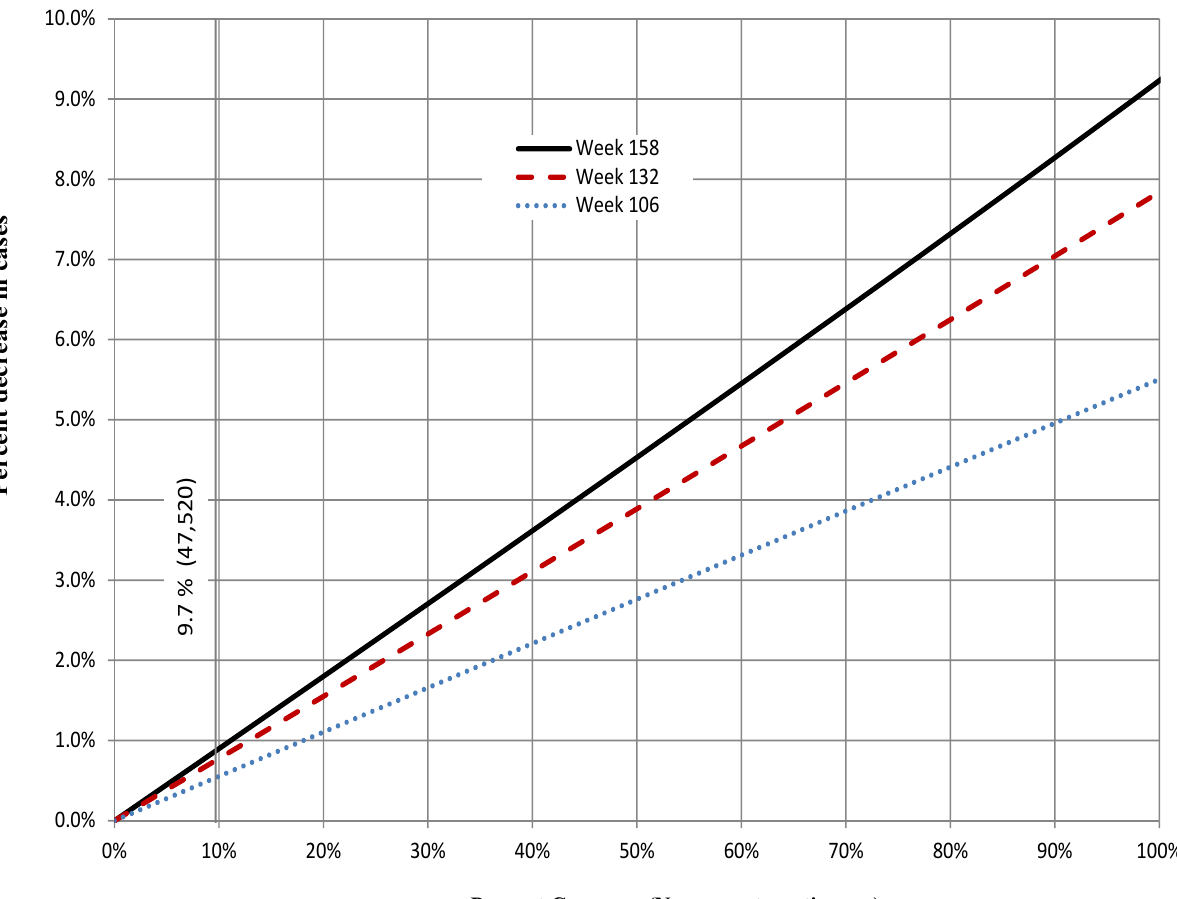
Figure 13. Ouest. The percent decrease in the total number of cases at Weeks 100, 125 and 150 for the percent of the non-symptomatic core group vaccinated indicated on the abscissa. The onset of the immune response was assumed to begin in Week 81 and complete in Week 85. We assume 70% efficacy of the vaccine. The actual number completing vaccination (47,520) is indicated by the vertical line. Percent reduction of cases resulting from